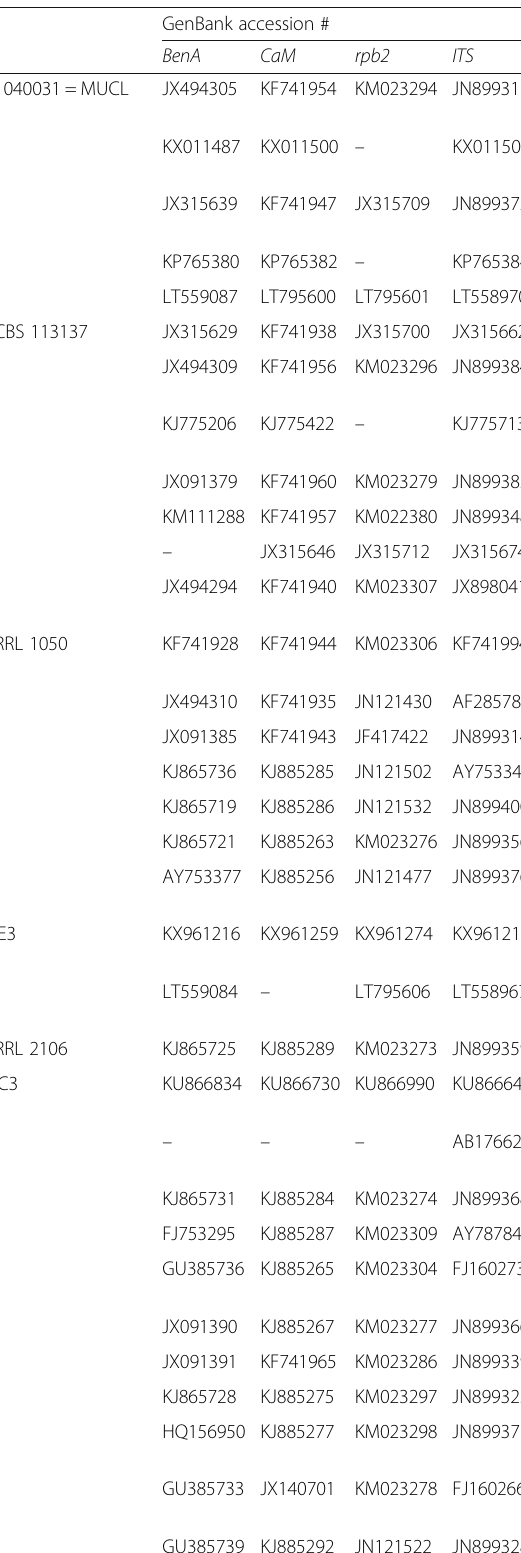
Table 2 Talaromyces spp. nucleotide sequences employed to build a phylogram to locate phylogenetically our strains from honey